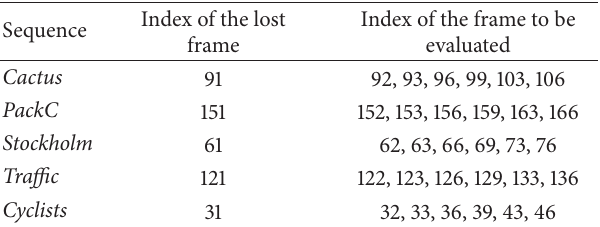
Table 9: Lost frame index of each sequence.